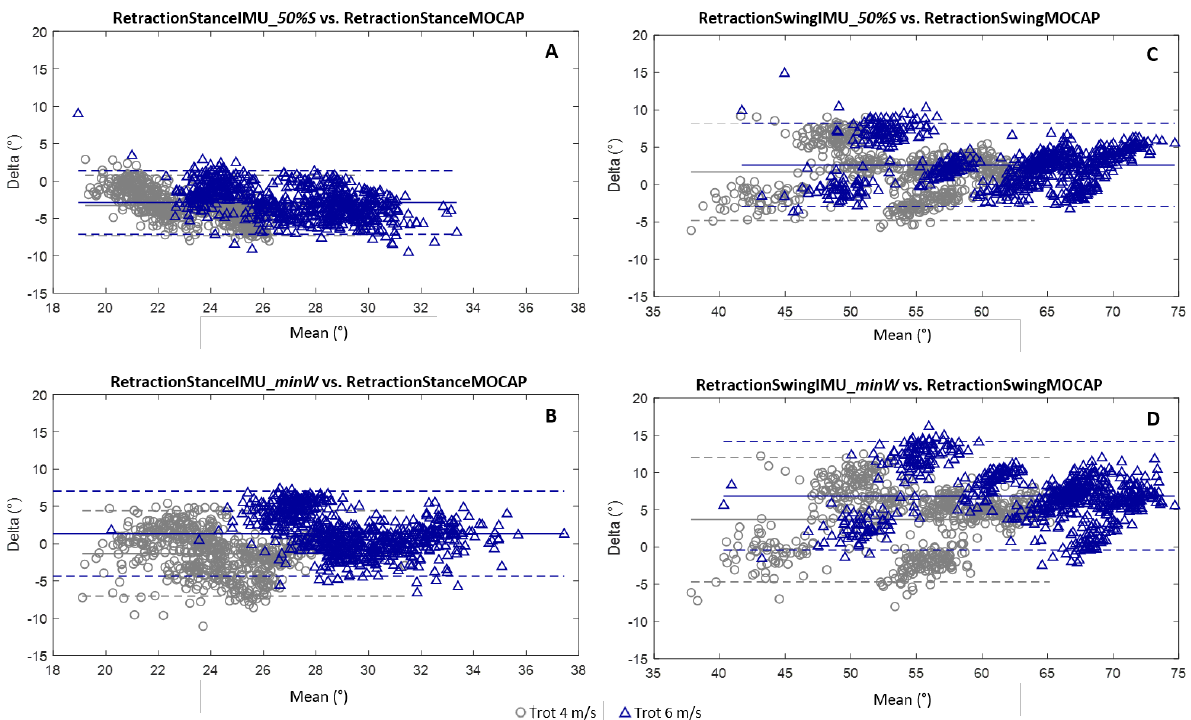
Figure 8. Bland–Altman graphs for the comparison of the retraction angles at a stance obtained using the indices 50%Stance ( A ) and minWithers ( B ) and of the angles of maximal retraction obtained using the indices 50%Stance ( C ) and minWithers ( D ) with the retraction angles, respectively, at a stance and at a swing obtained from the MOCAP data. The results for the 4 m/s trot are shown in gray (o) and the results for the 6 m/s trot are shown in blue (Δ). The accuracy (bias between the developed method and the MOCAP) and the limits of the confidence interval (95% of values) are shown for each graph.